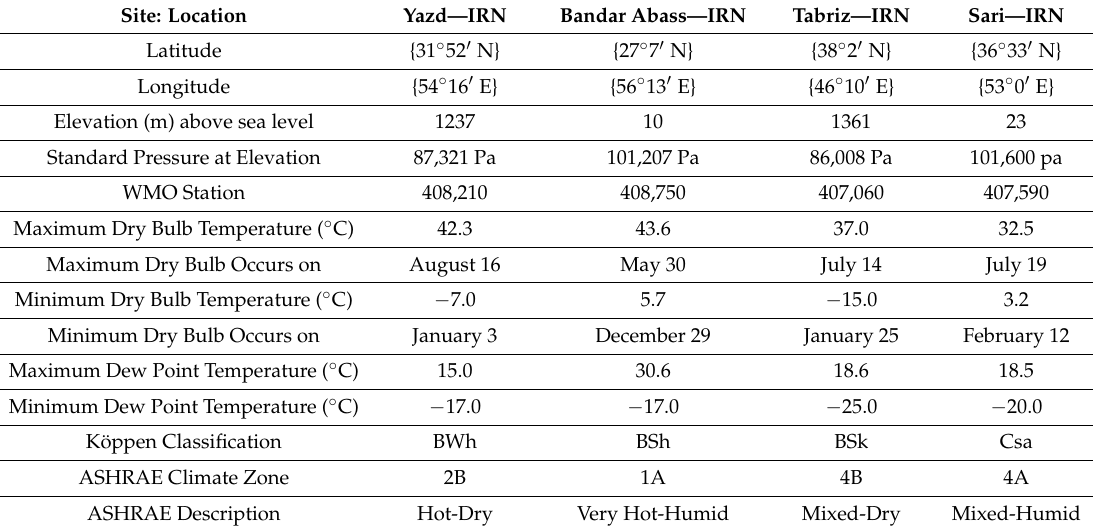
Figure 2. The building geometry and materials.